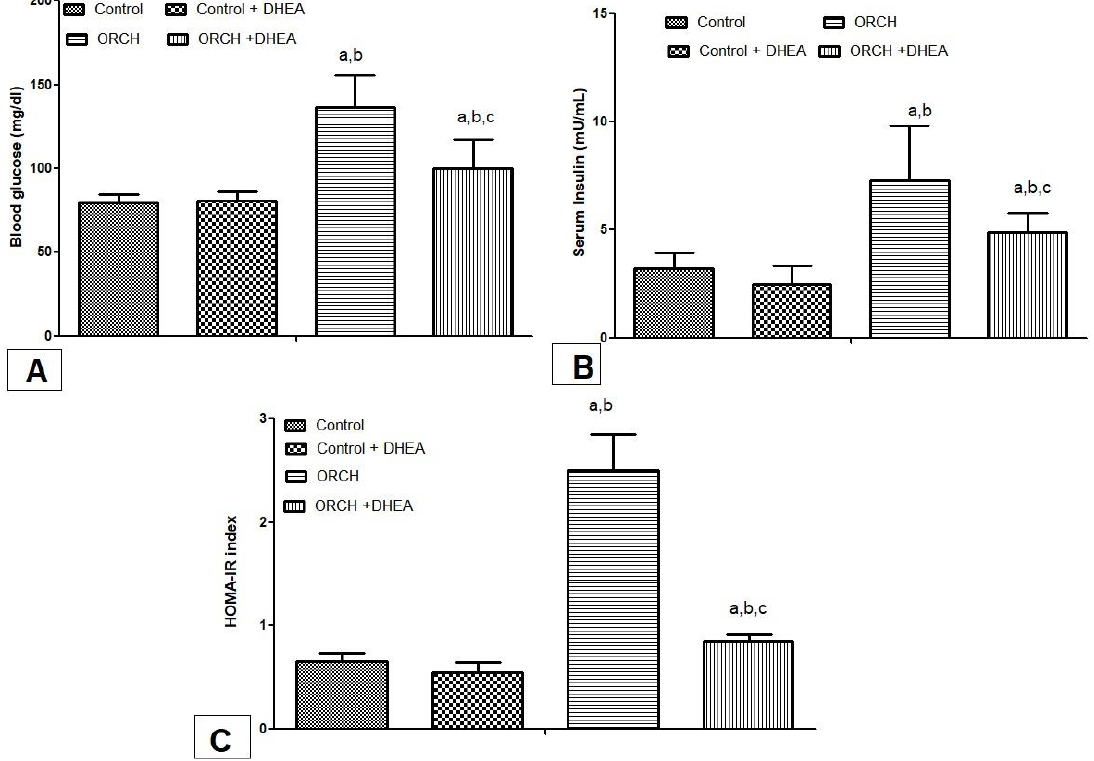
Figure 1. Effect of DHEA on ( A ) blood glucose level (mg/dL), ( B ) serum insulin (IU/mL), and ( C ) HOMA-IR index in orchidectomized rats. a : significance relative to control group, b : significance relative to Con + DHEA group, c : significance relative to ORCH. ORCH = orchidectomized rats and DHEA = dehydroepiandrosterone.